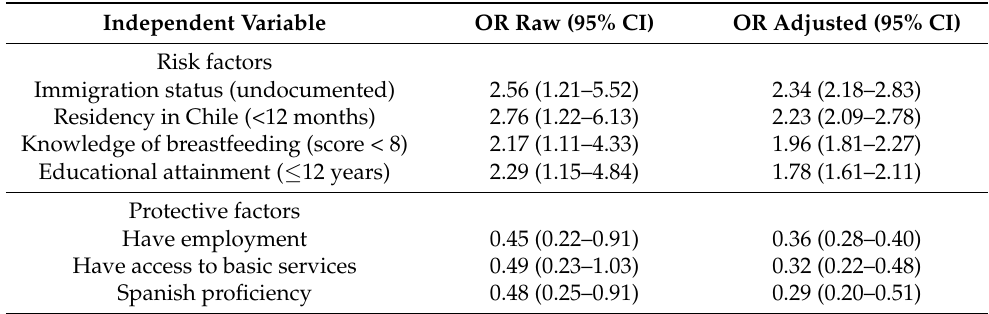
Table 3. Logistic regression model for the association between maternal factors and non-exclusive breastfeeding of Haitian immigrant women in southern Chile. Independent Variable OR Raw (95% CI) OR Adjusted (95% CI) Risk